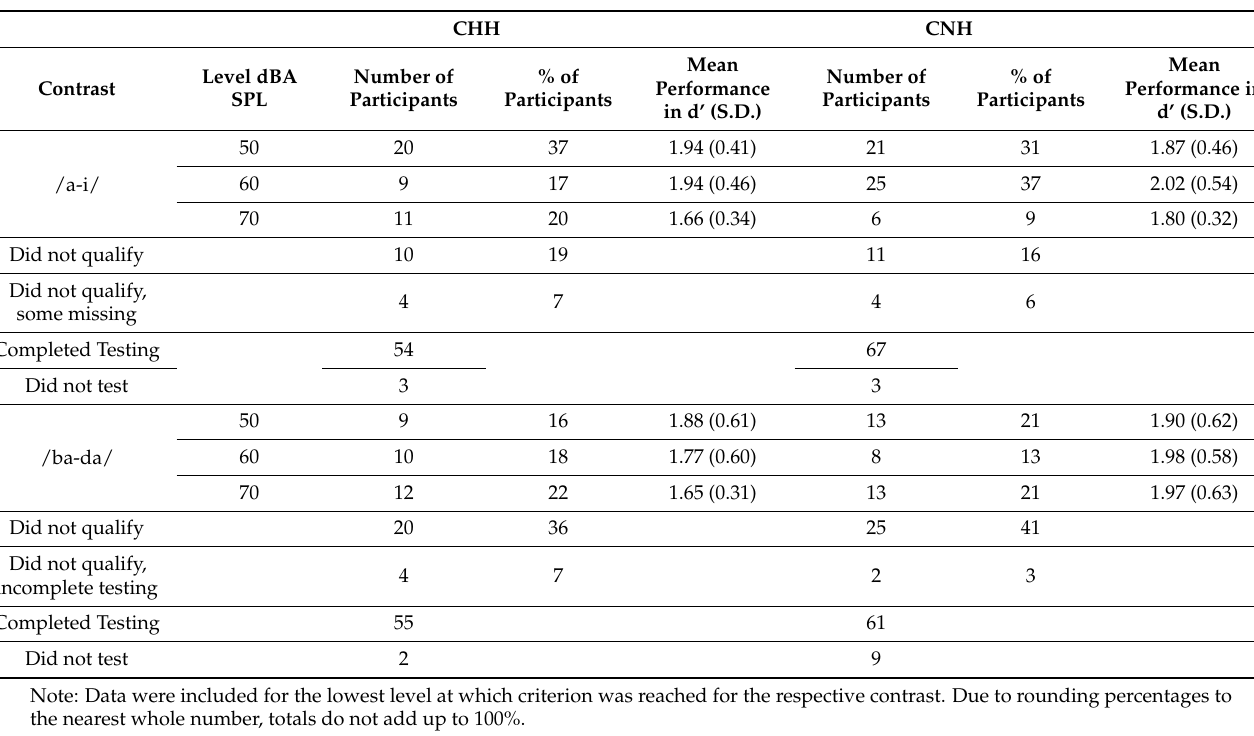
Table 3. Summary of speech perception.